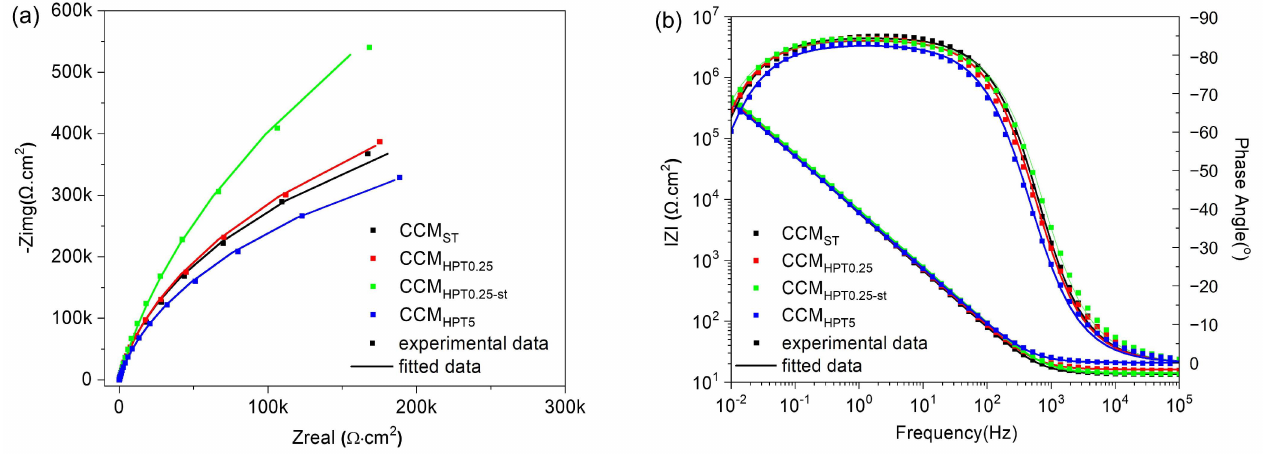
Figure 7. ( a ) Nyquist and ( b ) Bode diagrams of experimental data and fitted curves for CoCrMo samples. The impedance spectra were fitted to the electrical equivalent circuit (EEC) using Z-View software (version 2.9) by evaluating the quality of fitting through their chi-square ( χ 2) values. The native oxide film formed on surfaces of CCM samples contains electrolyte resistance, R e , native oxide film resistance (passive film), R ox , and constant phase element (CPE), Q ox , considering the nonideal capacitance of the native oxide film is presented by the EEC in Figure 9 [50]. EEC parameters are presented in Table 3 for CCM samples